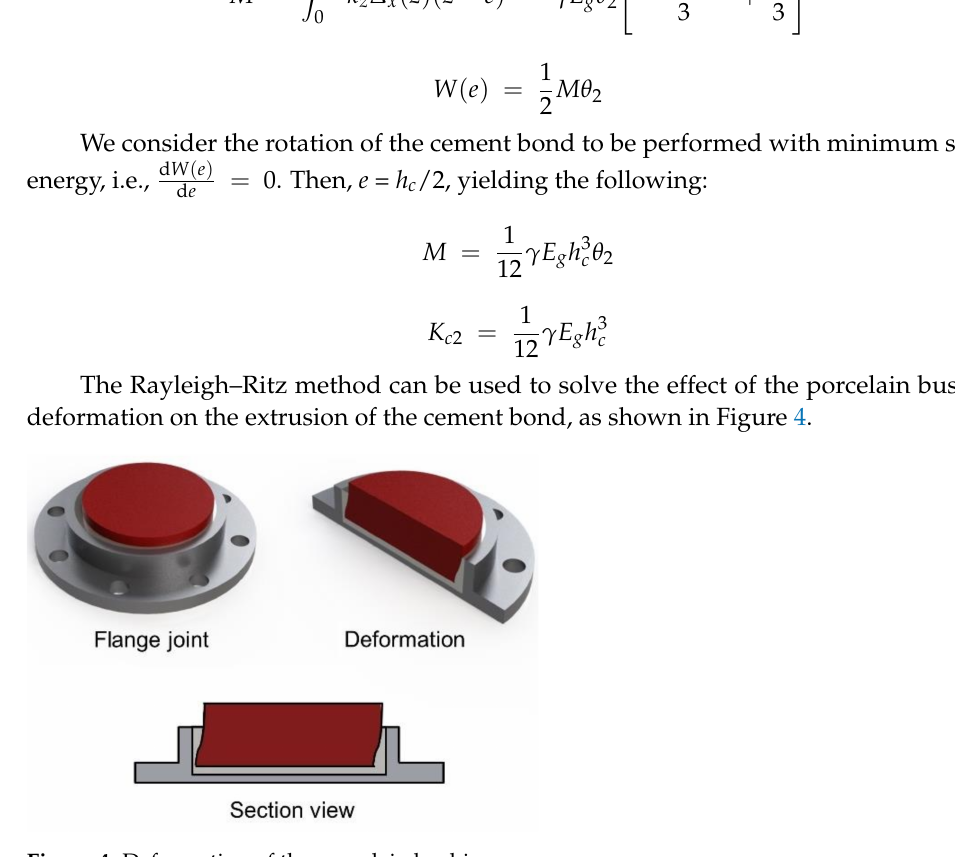
Figure 4. Deformation of the porcelain bushing.